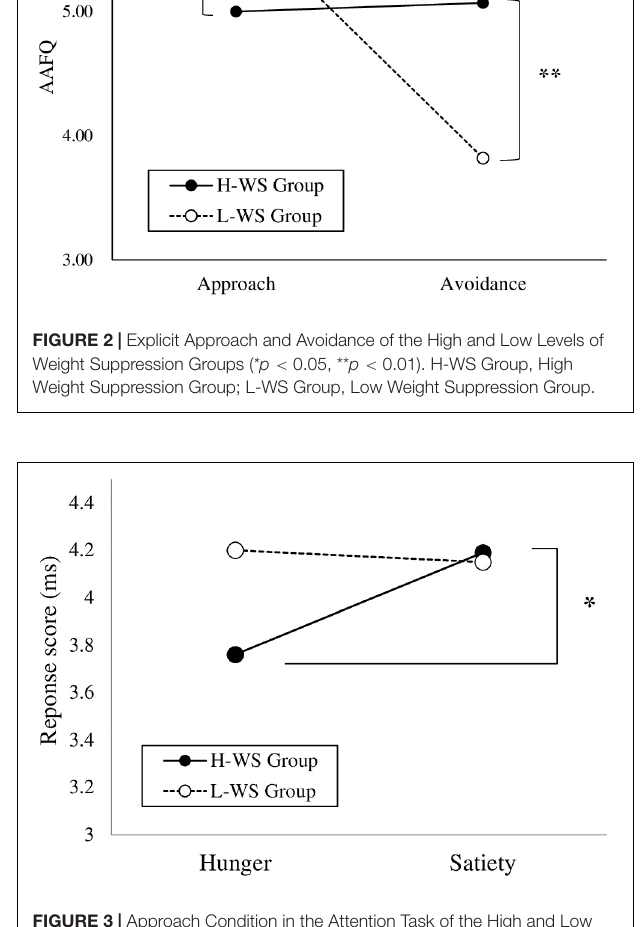
FIGURE 3 | Approach Condition in the Attention Task of the High and Low Levels of Weight Suppression Groups According to Hunger Level (* p <